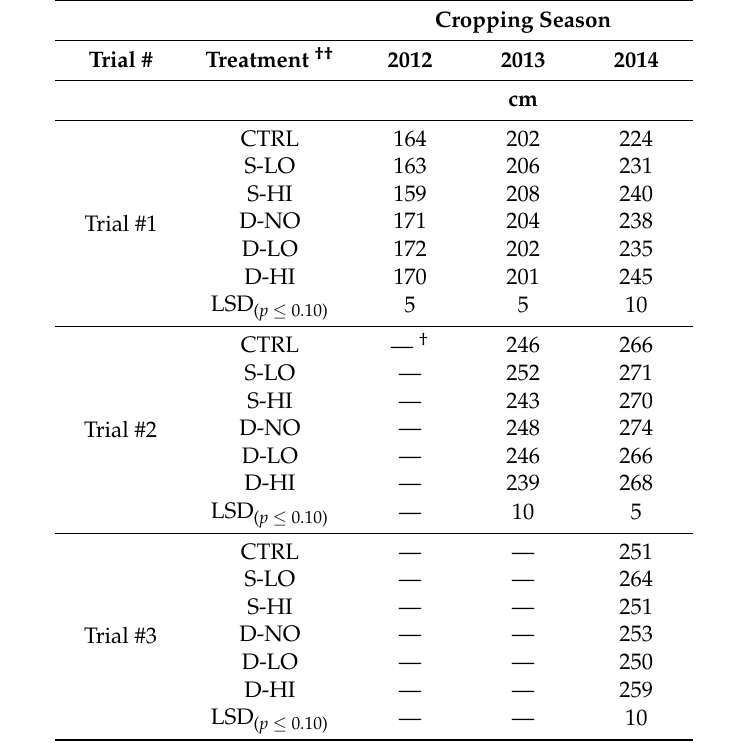
Table 2. VT (tassling) growth stage or later corn plant heights for lime treatments for all field trials from 2012 to